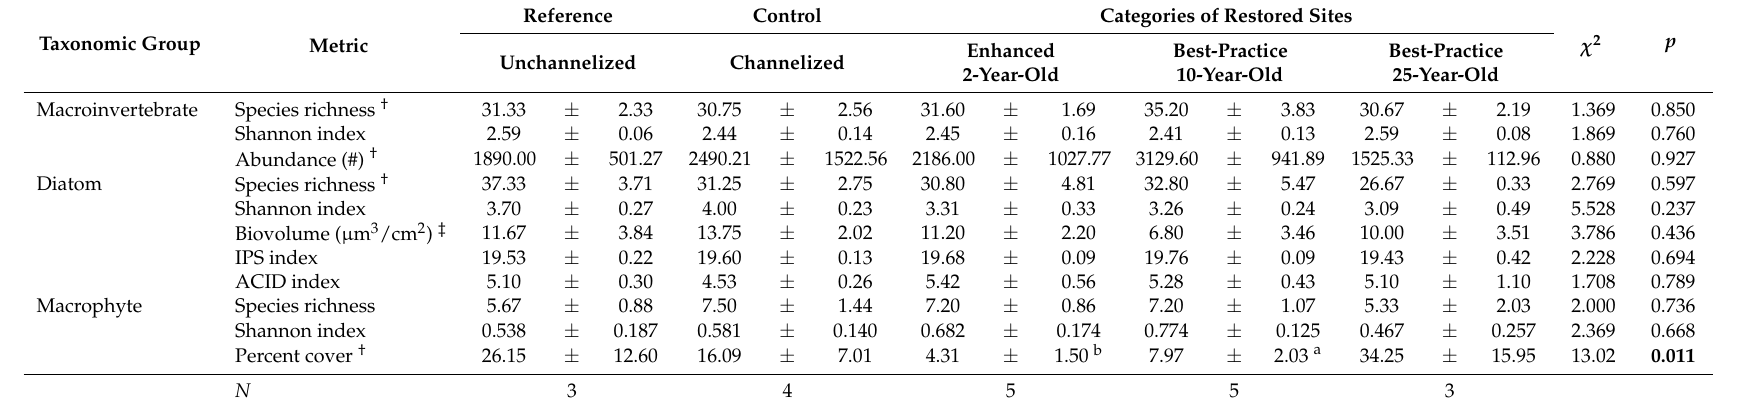
Table A3. Results of linear mixed-effect models (LMM) to determine differences among the different restoration statuses for species richness, Shannon index, and abundance. Differences in the site characteristics among the restoration statuses were determined using pairwise comparisons among the least-square means, and equivalent test to Tukey’s honest significant difference test for LMMs. Means and standard errors are reported; letters denote significant pairwise differences, values that share letters are not different from each